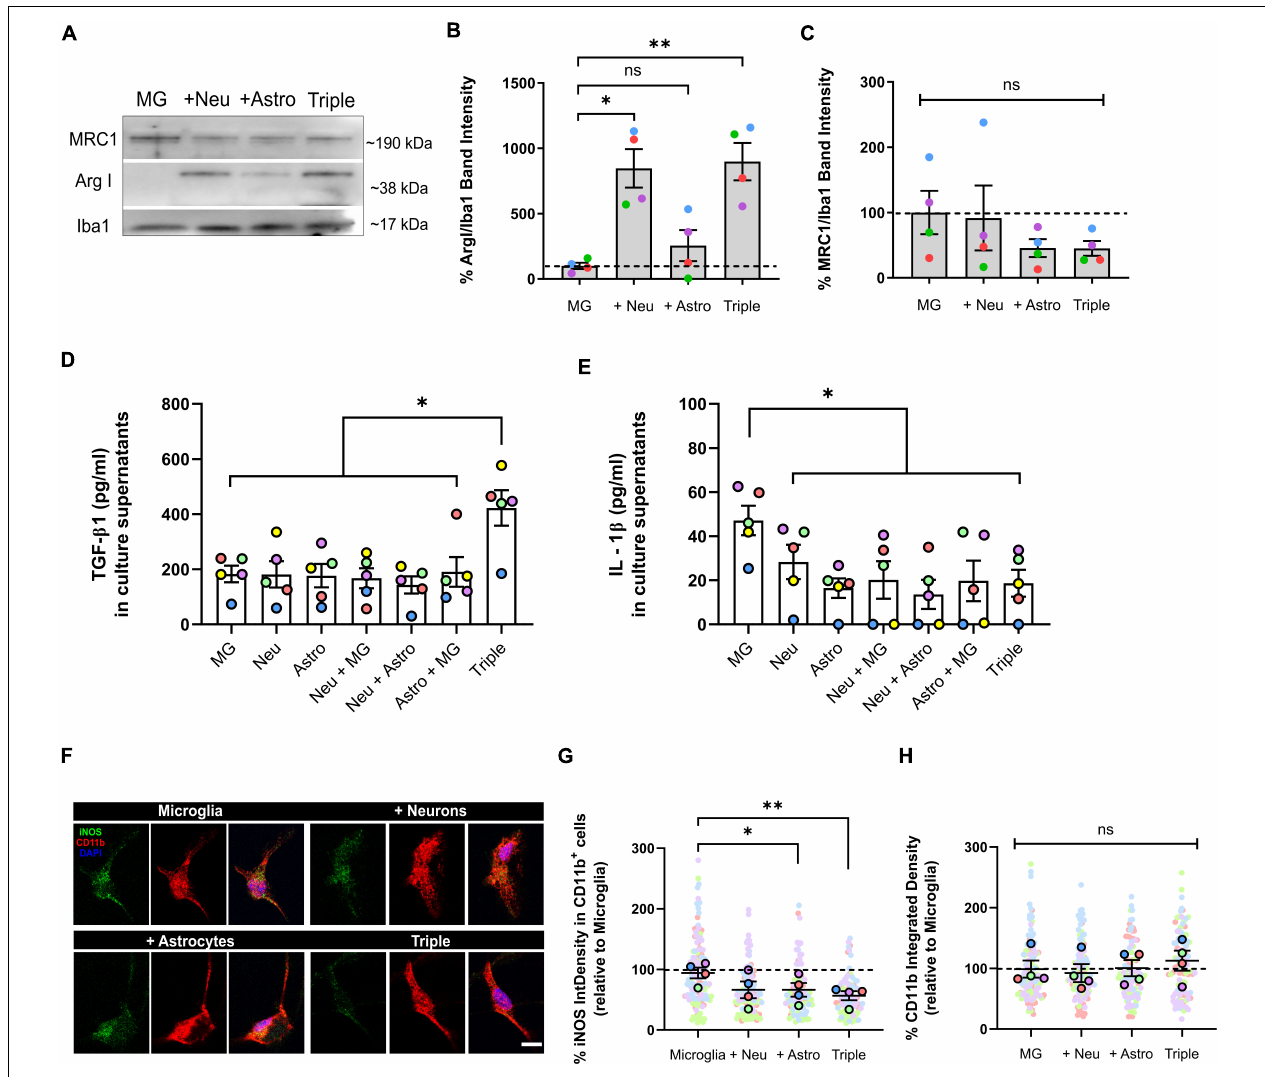
FIGURE 2 | Microglia increased the expression of anti-inflammatory markers ArgI and TGF- β 1, and decreased pro-inflammatory markers IL-1 β and iNOS in the triple co-culture model. (A) Representative western blot image of microglial markers in total cell lysates. (B) Quantification of anti-inflammatory marker ArgI ( n = 4). (C) Quantification of anti-inflammatory marker MRC1 ( n = 4). Data was normalized using the marker Iba1 in order to selectively control for microglia. (D) ELISA quantification of anti-inflammatory cytokine TGF- β 1 in culture supernatants ( n = 5). (E) ELISA quantification of pro-inflammatory cytokine IL-1 β in culture supernatants ( n = 5). (F) Representative image microglial markers CD11b and iNOS in individual cells. Scale bar = 10 µ m. (G) Quantification of the integrated density of iNOS inside CD11b + cells ( n = 4). (H) Quantification of the integrated density of CD11b ( n = 4). Each bar represents the mean ± SEM. * p < 0.05; ** p < 0.01; ns, not significant. For quantification, 5–6 random fields per condition were used. Neu, neurons; MG, microglia; Astro, astrocytes; ArgI, arginase I, IntDensity, integrated